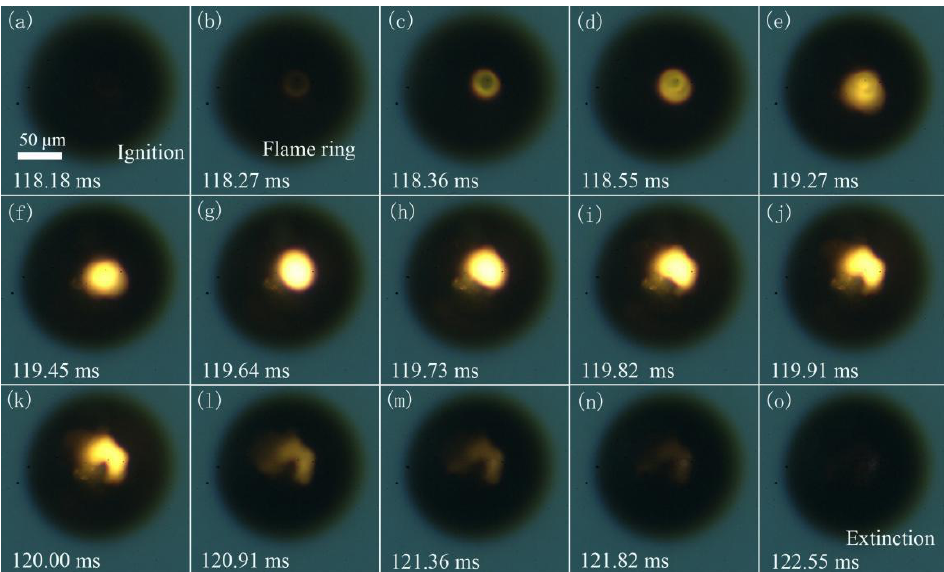
Figure 10. Representative snapshots of ignition and combustion stage of individual Mg microparticle. (Images acquired from Supplementary Materials, Video S1, recording frame: 11,000 fps; exposure time: 99 μs). ( a ) 118.18, ( b ) 118.27 ms, ( c ) 118.36 ms, ( d ) 118.55 ms, ( e ) 119.27 ms, ( f ) 119.45 ms, ( g ) 119.64 ms, ( h ) 119.73 ms, ( i ) 119.82 ms, ( j ) 119.91 ms, ( k ) 120.00 ms, ( l ) 120.91 ms, ( m ) 121.36 ms, ( n ) 121.82 ms, ( o ) 122.55 ms.